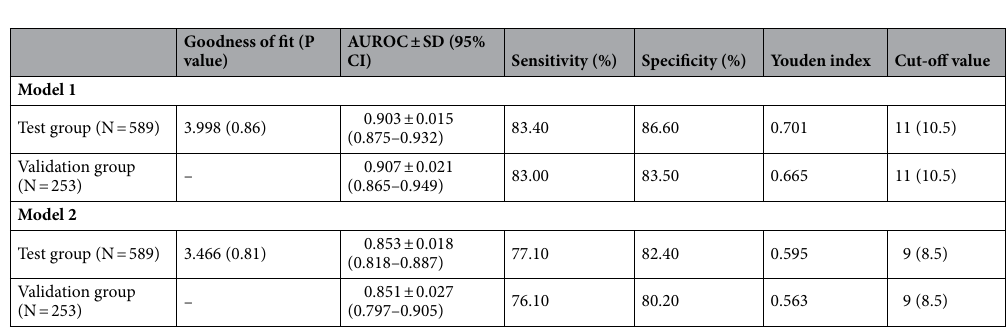
Table 3. Predictive performance of prediction model about elderly AKI patients within 30-day and 1-year all-cause death in the test and validation groups. AUROC the area under the receiver operating characteristic curves, SD standard deviation, CI confidence